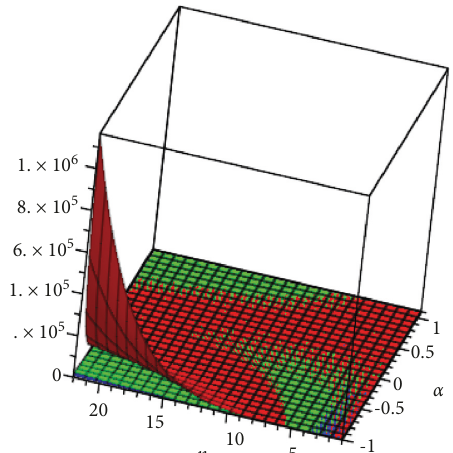
, ψ ω , and ψ ω for NP n . 1 2